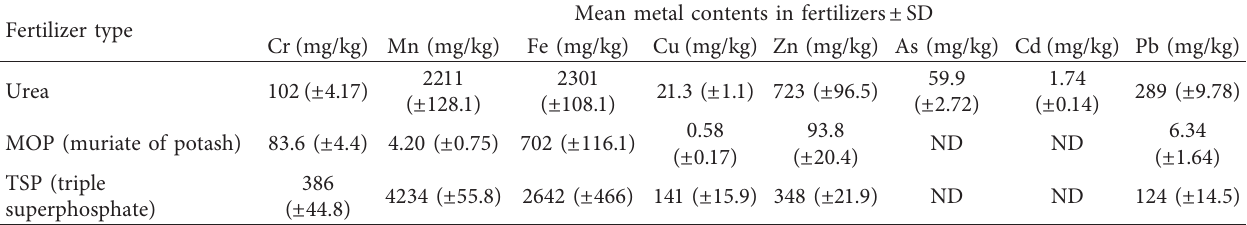
Table 6: Selected heavy metal/metalloid contents in fertilizer samples collected from the selected CKDu endemic area. Mean metal contents in fertilizers ± Fertilizer type